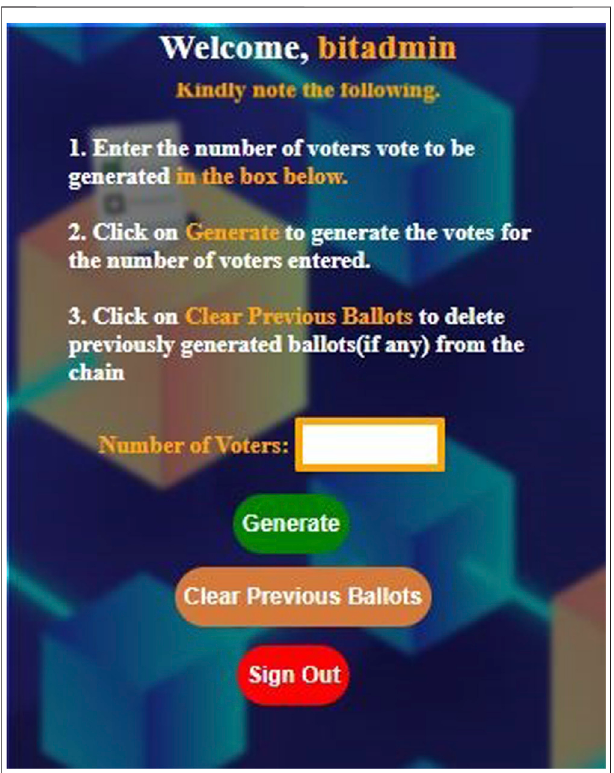
FIGURE 5 | System testing